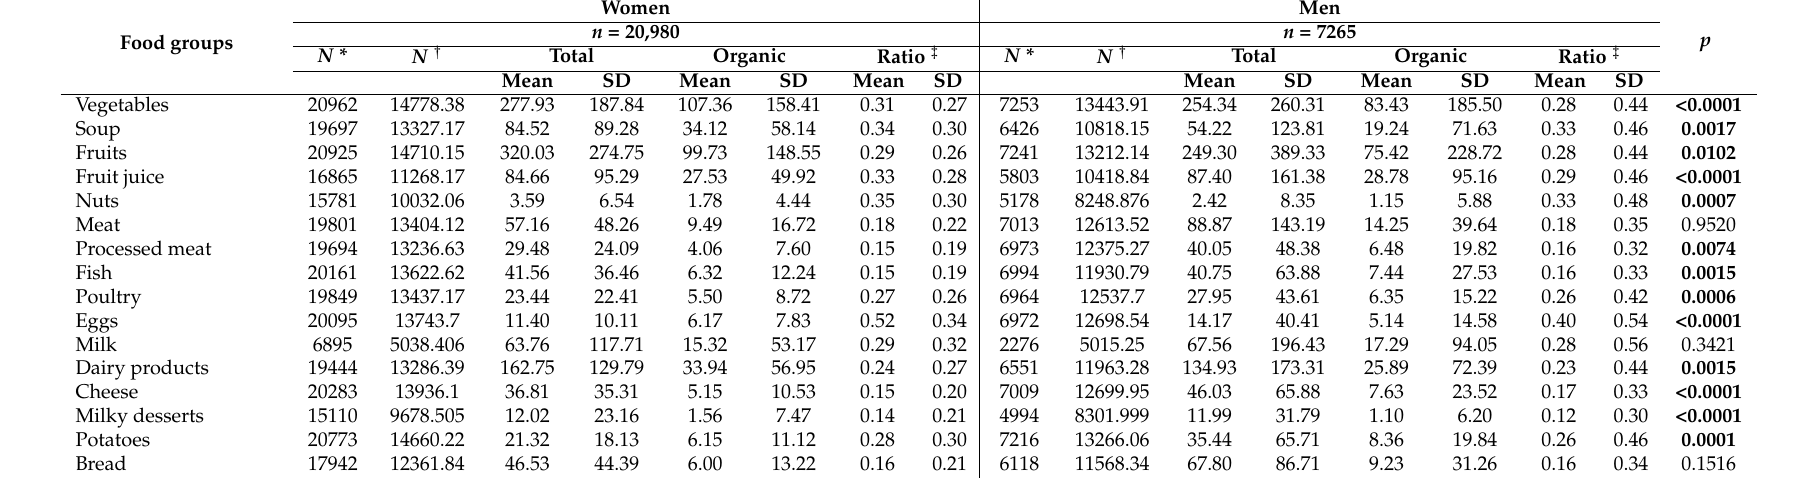
Table 3. Share of organic food by food groups by gender (g/day), NutriNet-Santé Study, N =